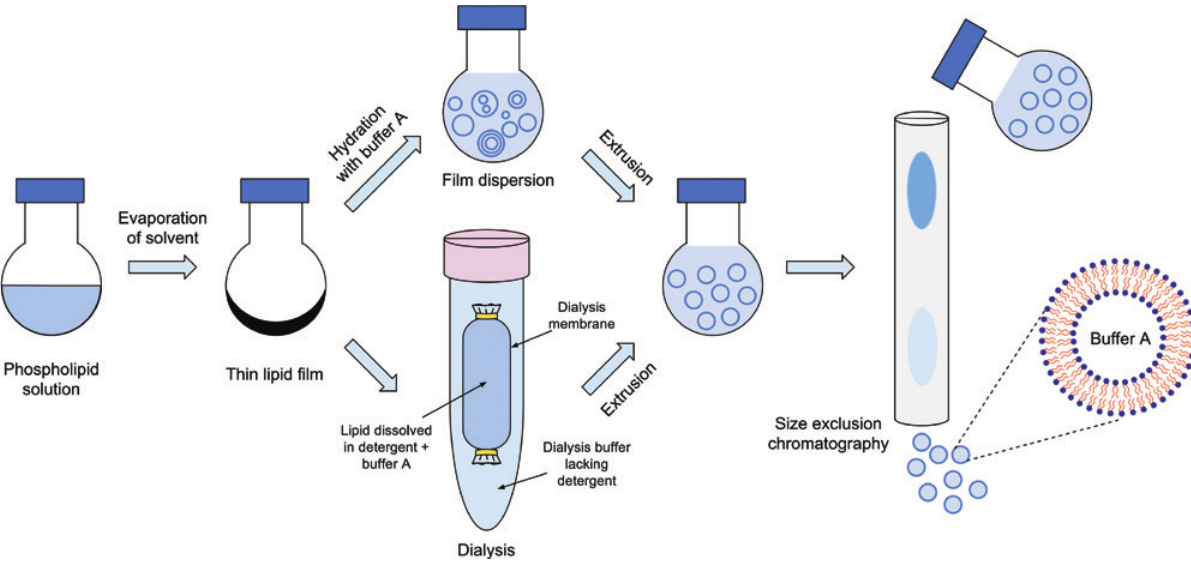
Figure 1: Liposome formation by the film dispersion and dialysis methods. The extrusion step promotes the formation of unilamellar liposomes of uniform size. Size exclusion chromatography decreases the size variation and can be used to exchange the dispersion buffer. The liposomes shown in Figures 3–6 and employed to obtain the proteoliposomes shown in Figure 7 were prepared by the film dispersion method and manually extruded 11 times through a polycarbonate filter (pore size of 100 or 200 nm) using a mini-extruder (Avanti Polar Lipid Inc.,